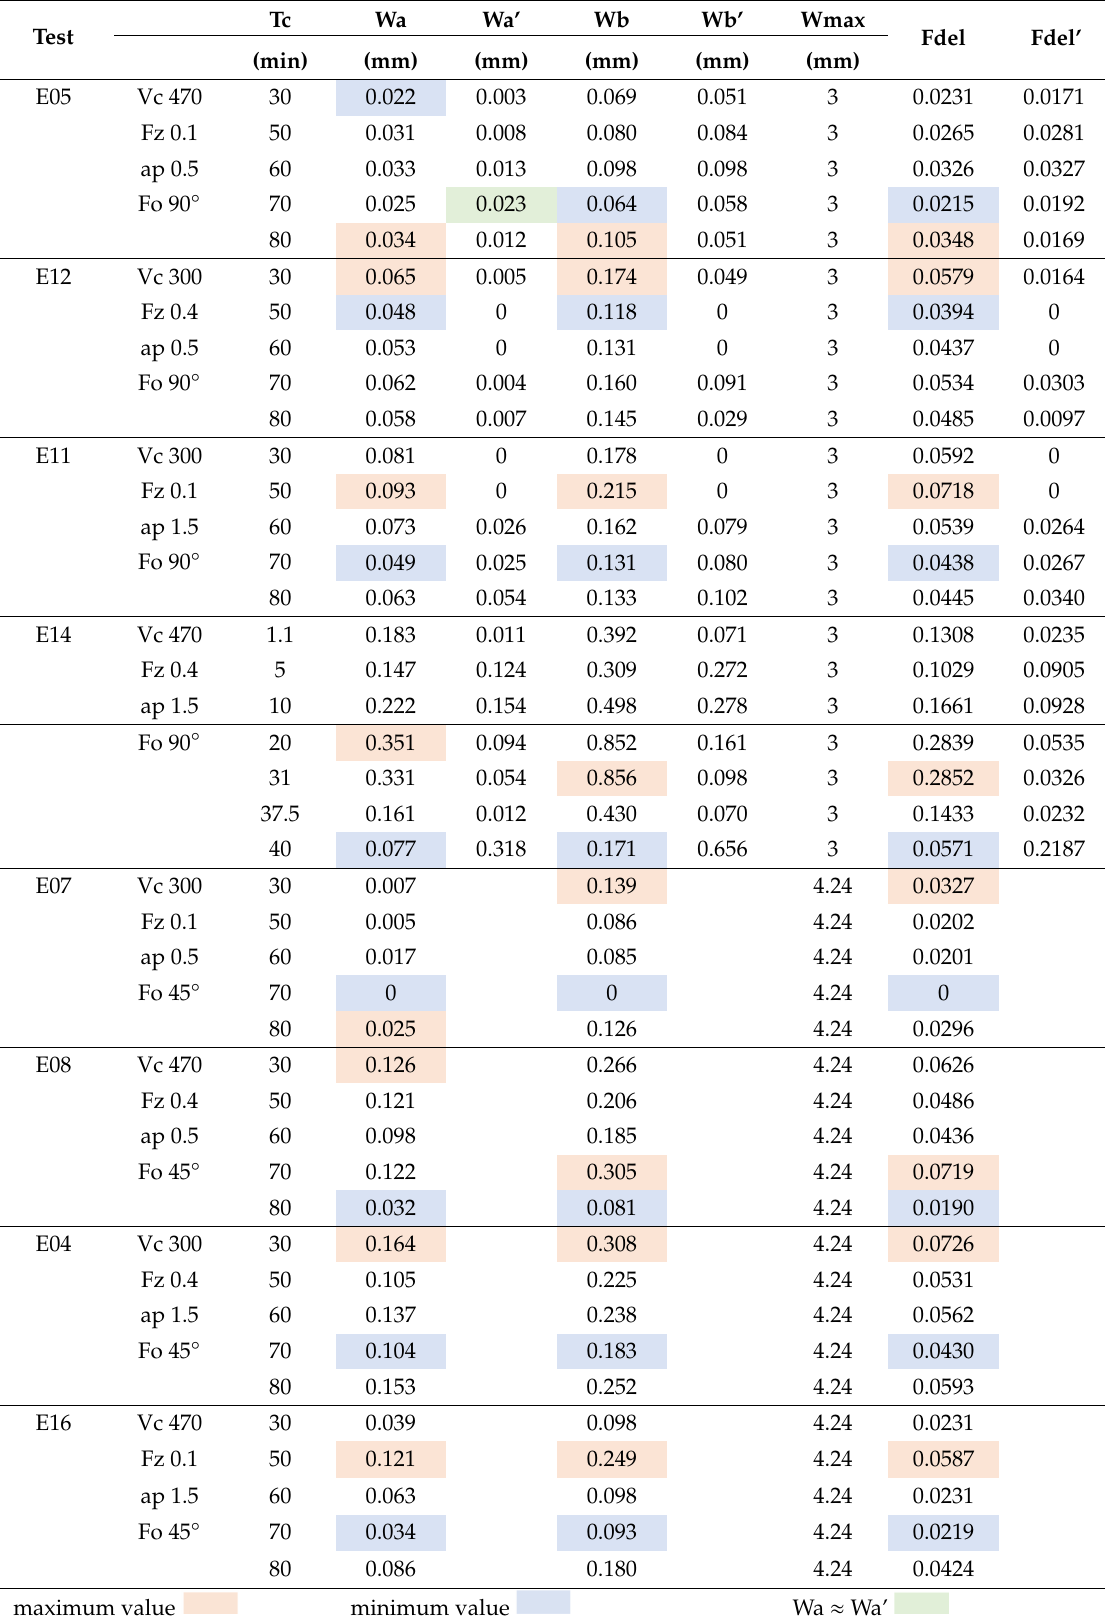
Table 4. Parameter values in Type I